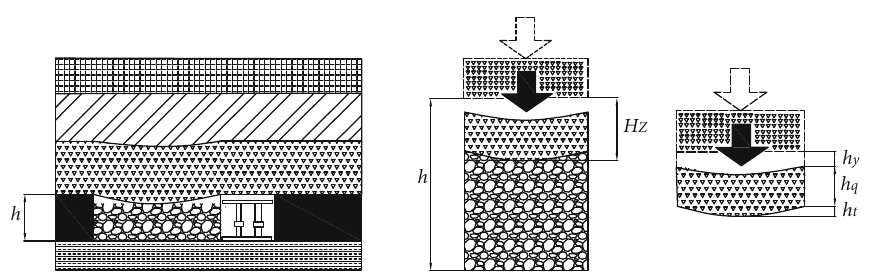
Figure 5: Equivalent mining height model of solid back fi lling.